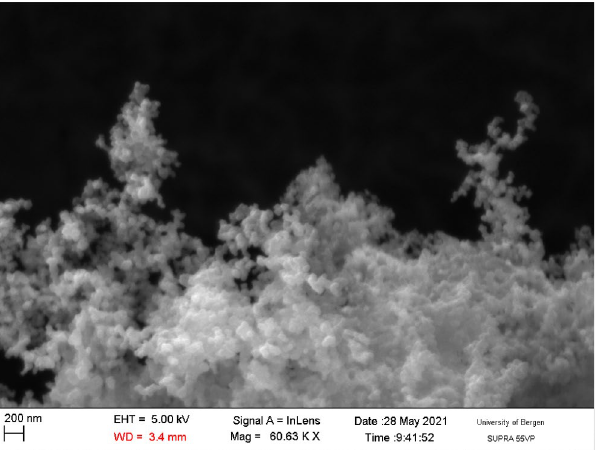
Figure 1. Scanning electron microscopy image of the carbon black nanoparticles investigated in this